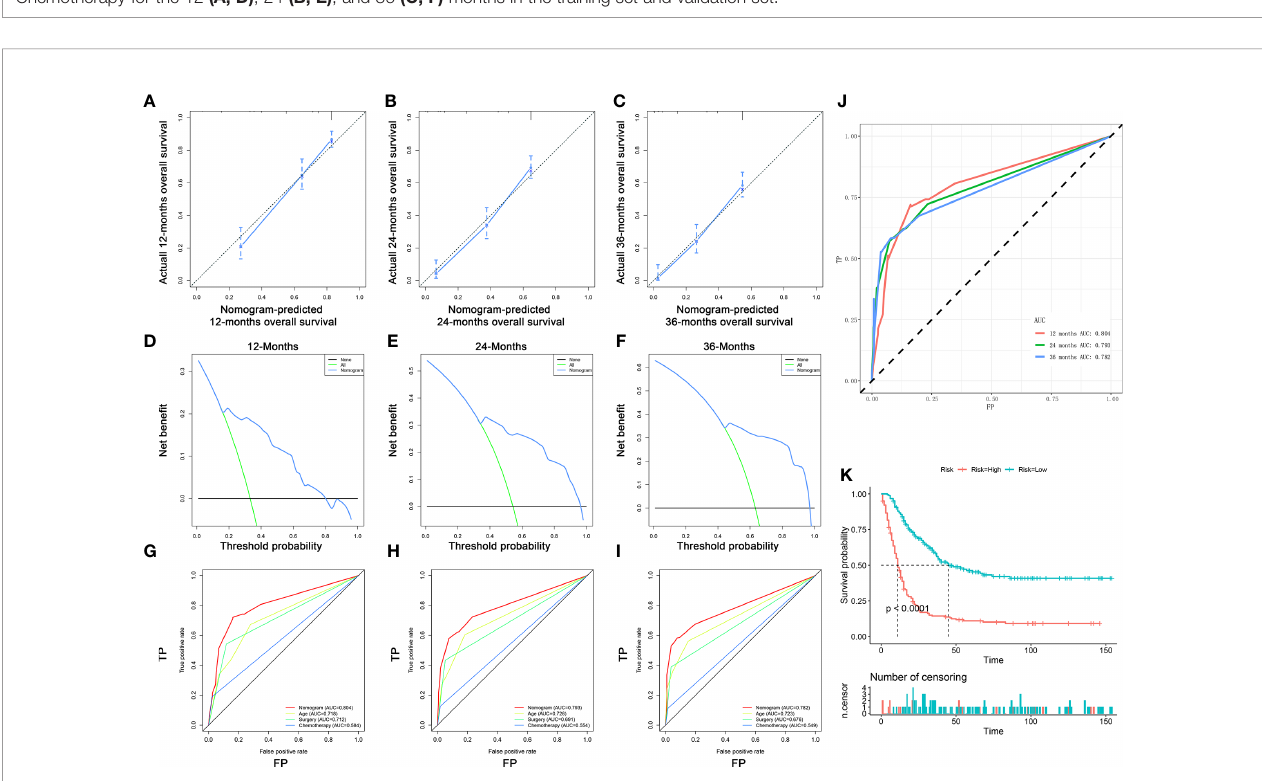
FIGURE 8 | Validating the prognostic nomogram in the expanded testing set. The calibration curves of the nomogram for the 12 (A) , 24 (B) , and 36 months (C) in the expanded testing set. The decision curve analysis of the nomogram for the 12 (D) , 24 (E) , and 36 months (F) in the expanded testing set. Comparison of area under the receiver operating characteristic curves between nomogram and all independent factors for the 12 (G) , 24 (H) , and 36 (I) months in the expanded testing set. (J) Time-dependent ROC curve analysis of the nomogram for the 12, 24, and 36 months in the expanded testing set. (K) The Kaplan – Meier survival curve of the patients in the expanded testing